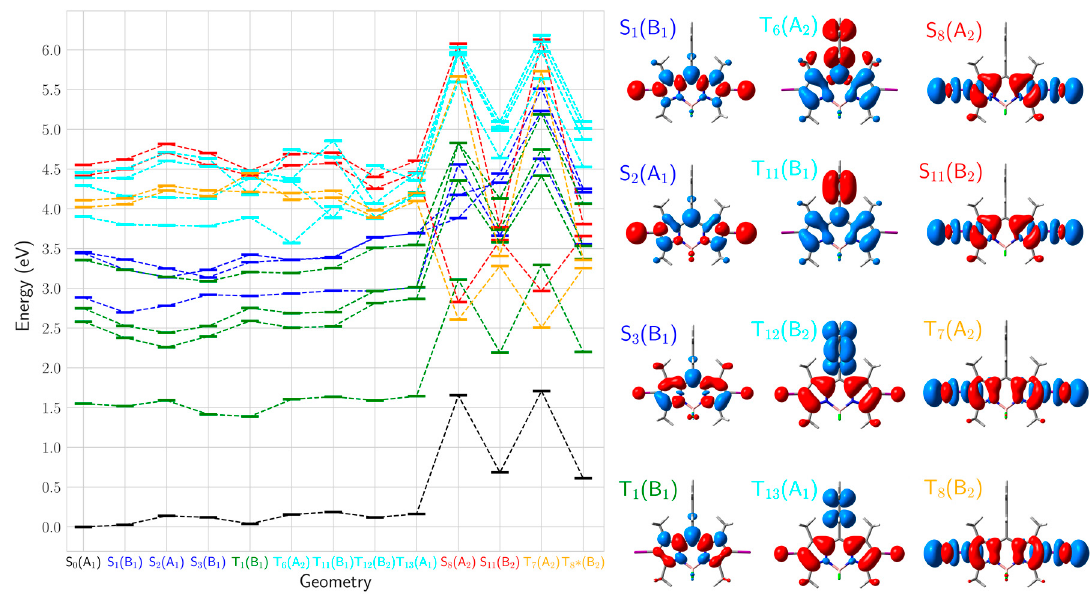
Figure 1. TDDFT geometry-states correlation diagram and charge density differences of the corresponding states. Asterisks indicate non-converged geometries, where the last step of the optimization procedure has been taken. Color code: singlet ground state (black), singlet state of IL character (blue), dissociative singlet state (red), triplet state of IL character (green), dissociative triplet state (orange), and triplet CT state (cyan).